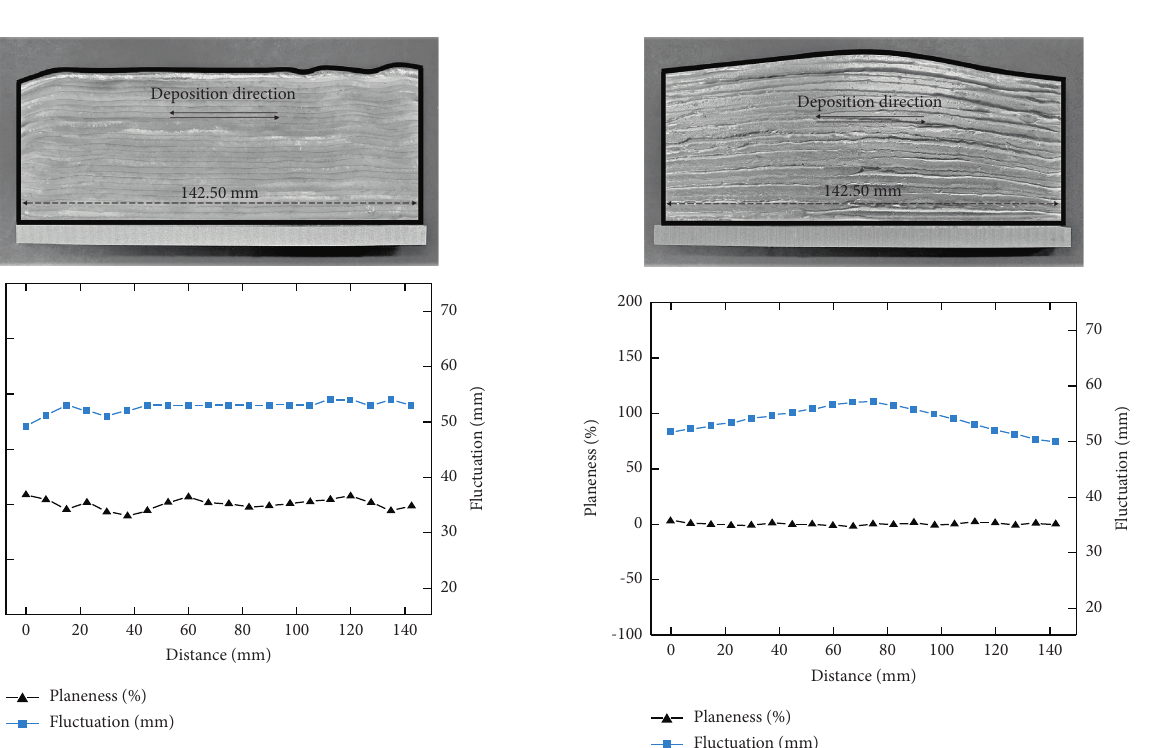
Figure 6: Side flatness and top surface volatility of the deposition wall without path